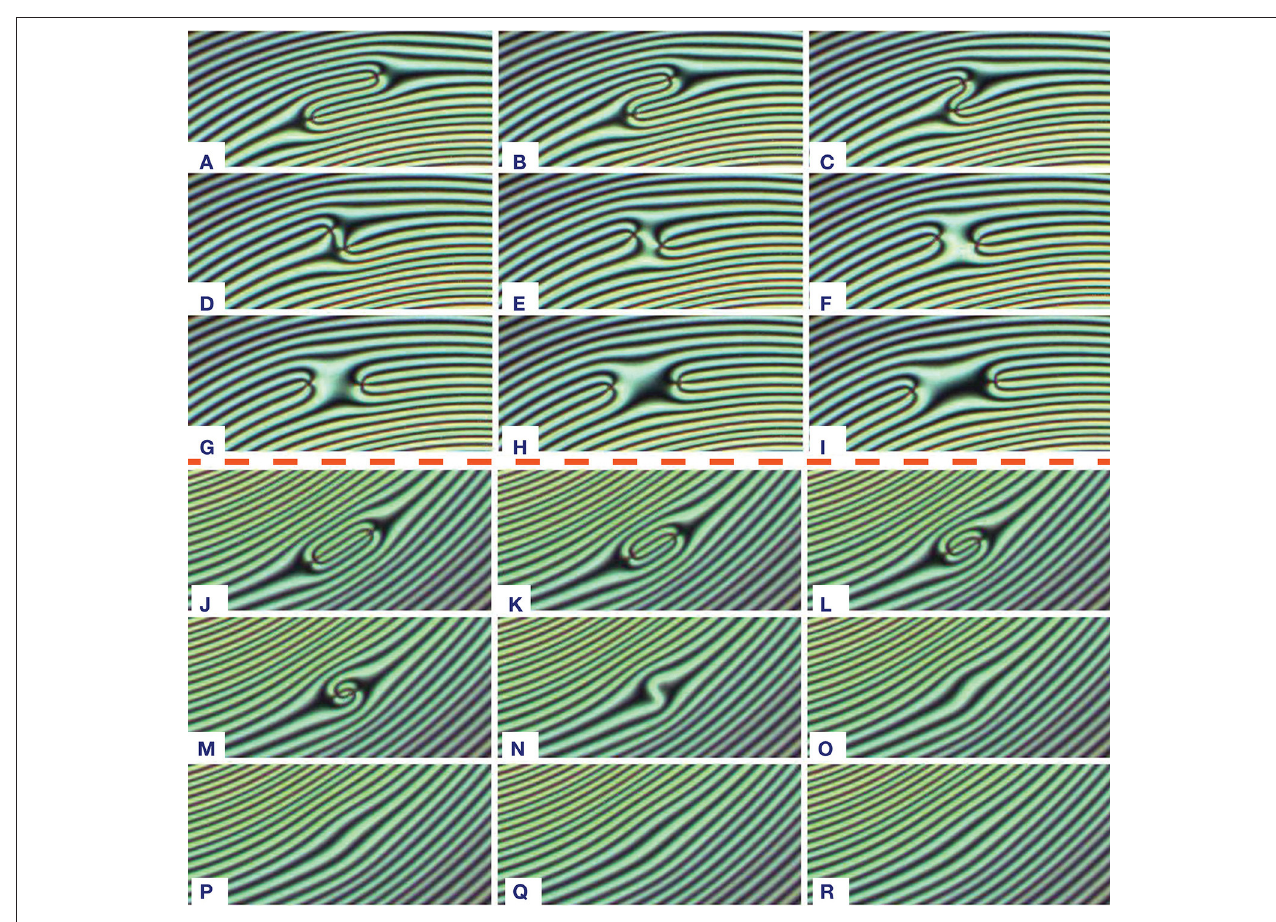
FIGURE 14 | Criterium for the outcome of collisions. (A–I) When | 1ϕ | > π , annihilation is avoided. Here, | 1ϕ | ≈ 3 π/ 2. Pictures taken at intervals of 10 s. (J–R) When | 1ϕ | < π , annihilation occurs. Here, | 1ϕ | ≈ π/ 2. Pictures taken at intervals of 5 s.